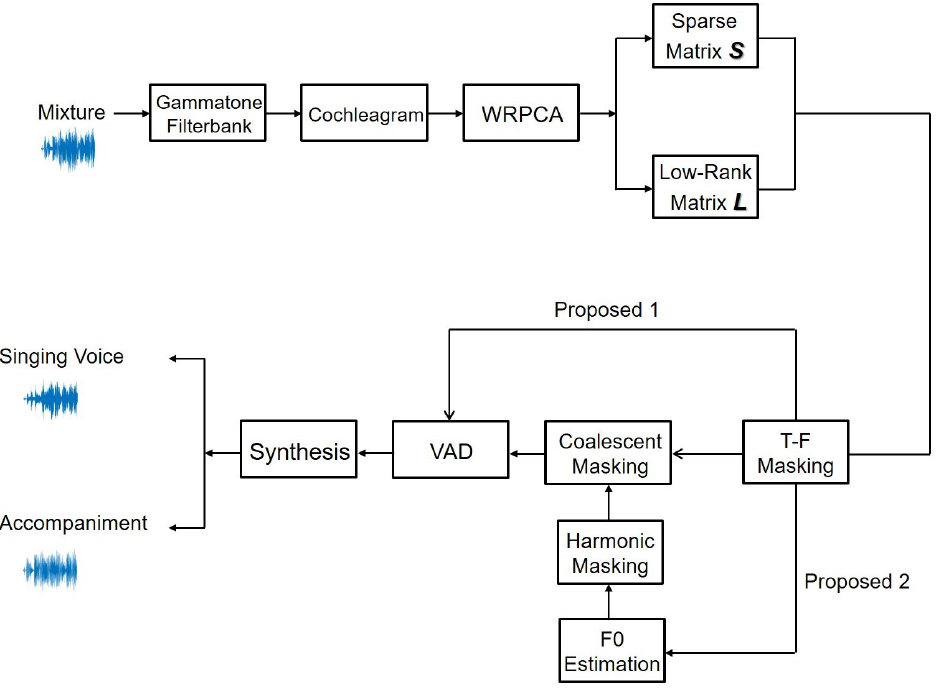
Figure 4. The architecture of the proposed SVS